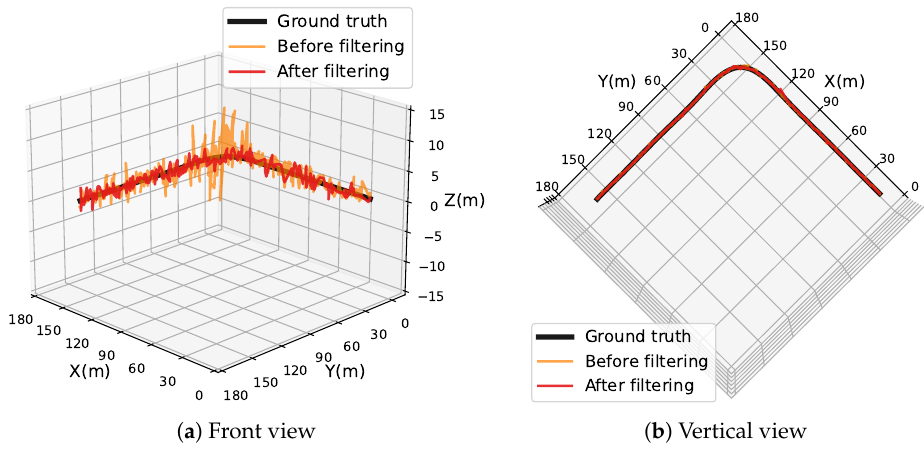
Figure 8. Paths of geolocation in the experiment of corresponding point